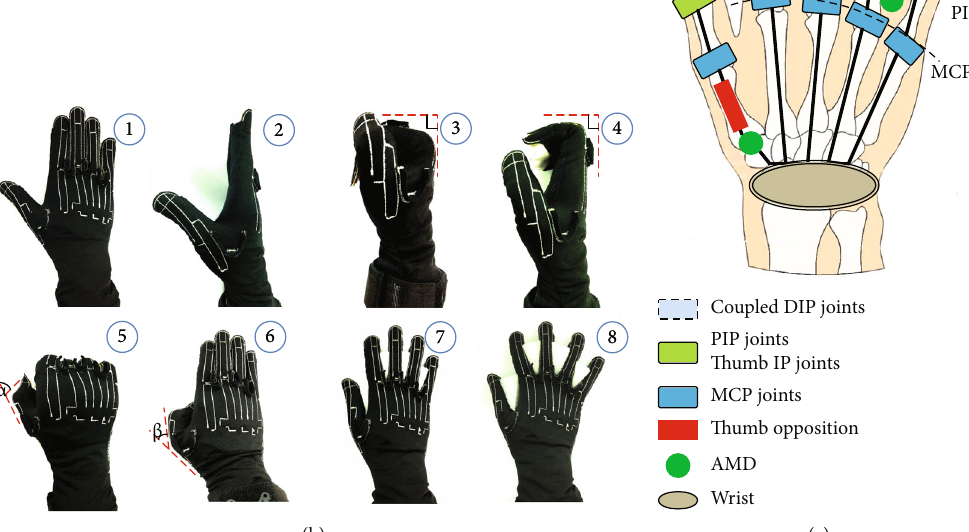
Figure 3: Calibration, recording, and reconstruction system: (a) calibration, recording, and reconstruction system; (b) Cyberglove calibration; (c) schema of the Cyberglove kinematic model contained 15 active